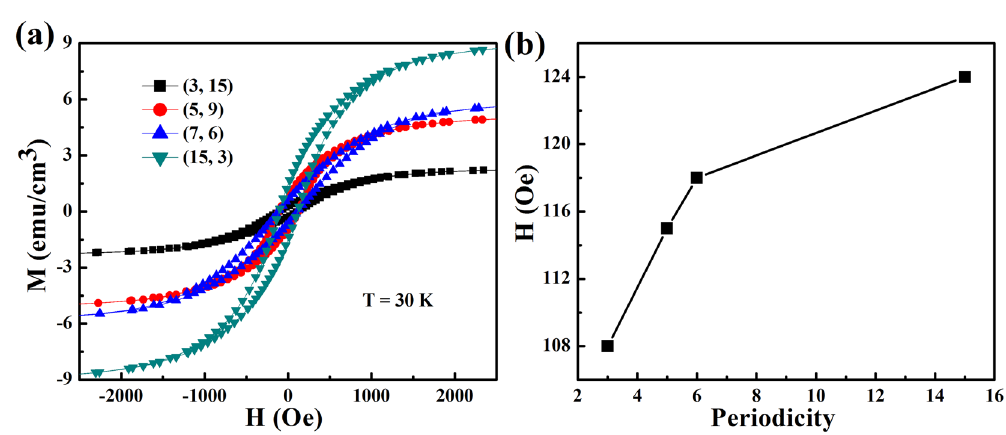
Figure 5. Magnetic measurements. ( a ) M-H hysteresis loops for (3, 15), (7, 6), (5, 9) and (15, 3) SLs measured at 30 K. ( b ) Comparison of the thickness dependence of magnetic coercivity for various SLs at T = 30